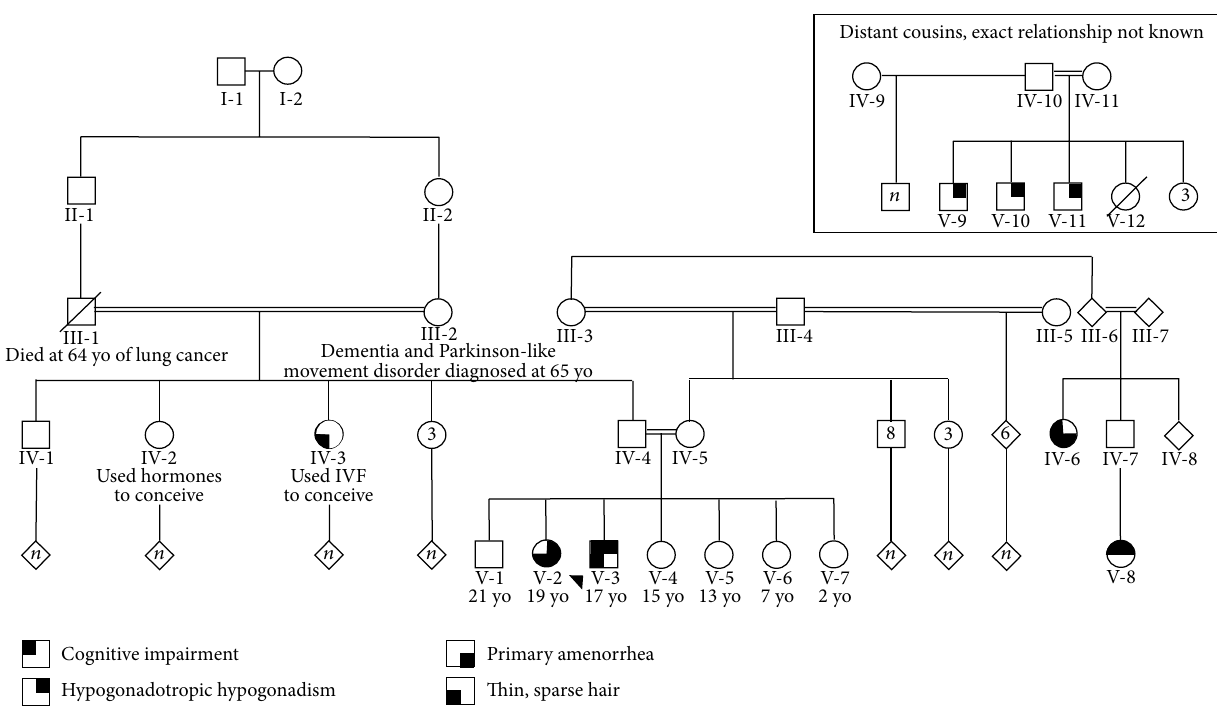
Figure 1: Pedigree illustrating multiple instances of consanguinity. Patient 1 (V-3), the proband, is indicated with an arrow. The proband’s parents (IV-4 and IV-5) shared a common grandfather approximately 5 generations ago. Individual’s clinical phenotypes are specified according to the key. The individuals in the inset are related to both the maternal and paternal lineages, but exact relationships are not